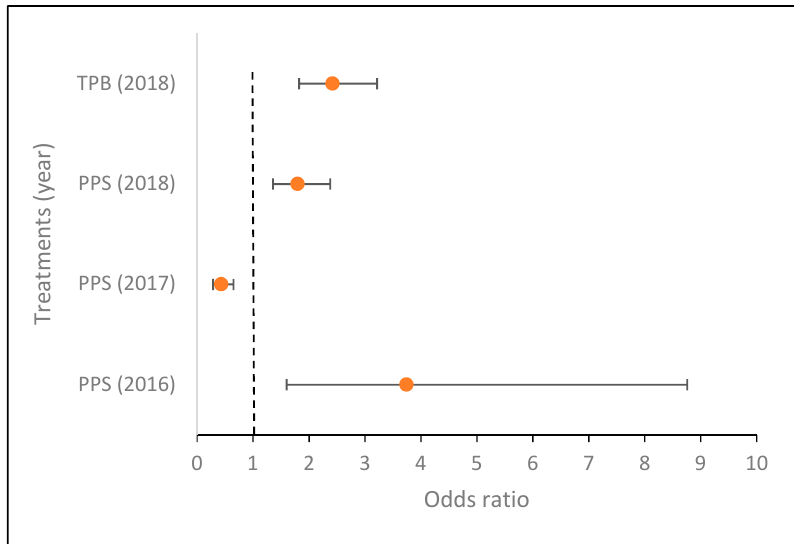
Figure 2. Effects of the four treatments with significant effects on the likelihood of Streptomyces sp. tuber infection (compared to control) assessed in three consecutive years. Treatments: PPS contains Pseudomonas protegens , Pseudomonas jessenii , and Stenotrophomonas maltophilia ; TPB contains Trichoderma atroviride , Pseudomonas putida , and Bacillus subtilis. The vertical (Y) axis shows the treatments with significant results, the horizontal (X) axis shows the odds ratios, n = 400 in each group.